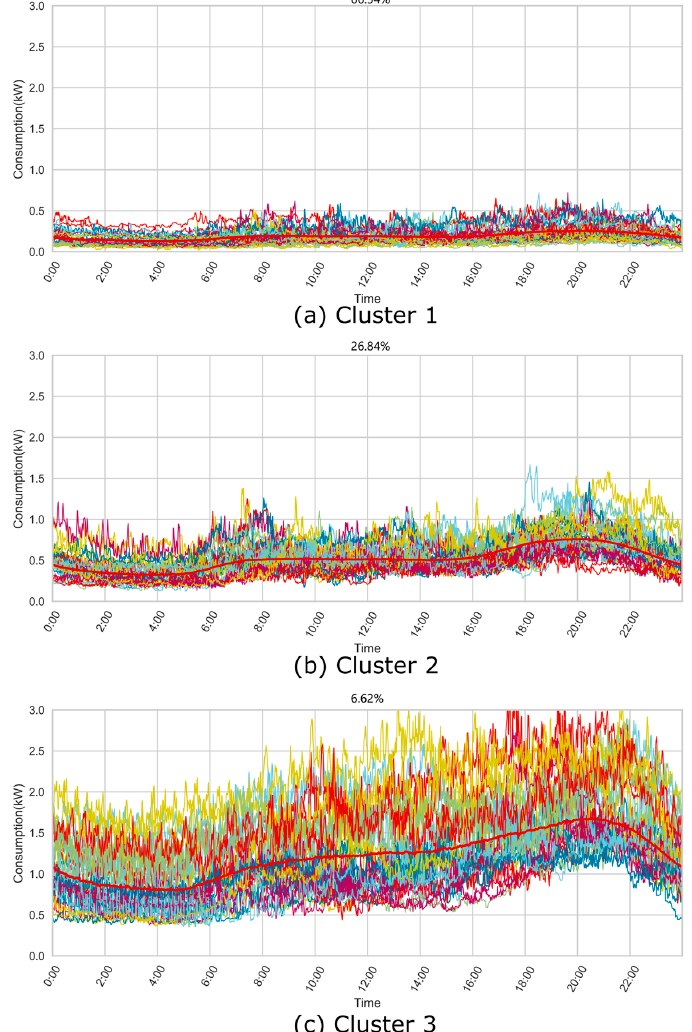
Figure 12. Daily load curves and load patterns of each cluster, ( a ) low load consumption group, ( b ) middle load consumption group, and ( c ) high load consumption and instability group.